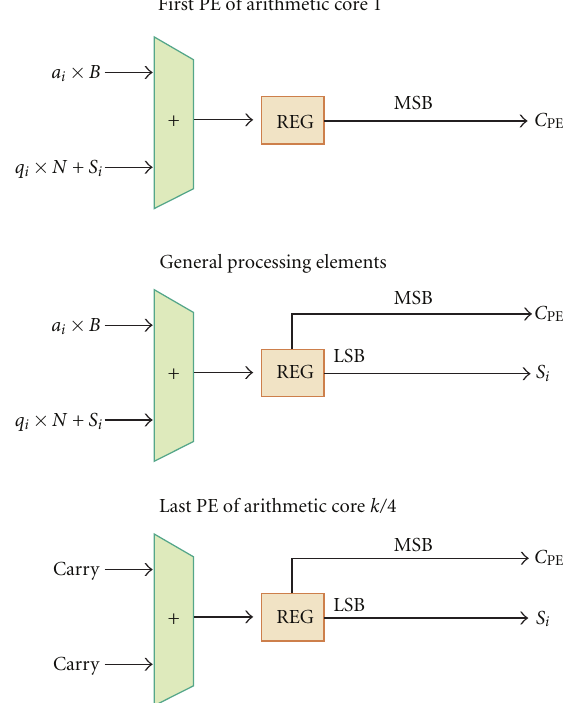
Figure 10: General PE with the carry